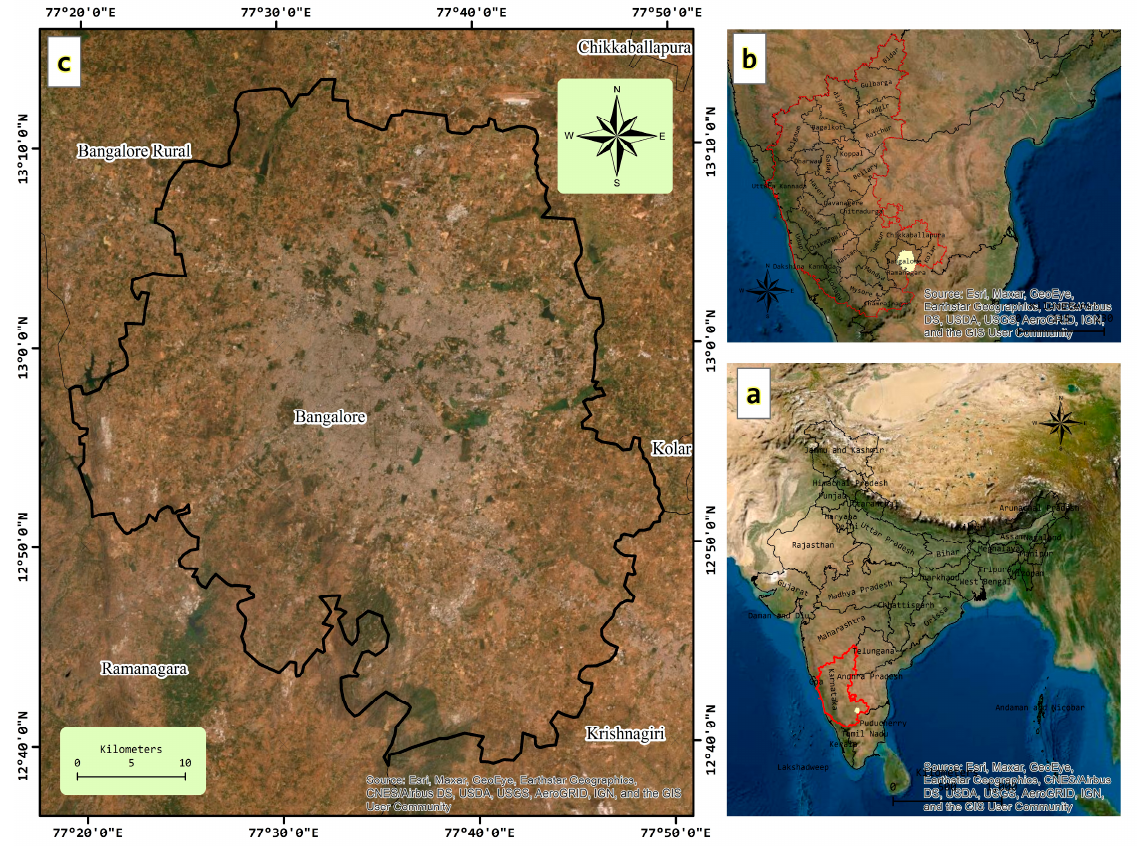
Figure 1. ( a ) India, ( b ) State of Karnataka (red boundary), and ( c ) Bangalore city. Map coordinates are WGS 84.